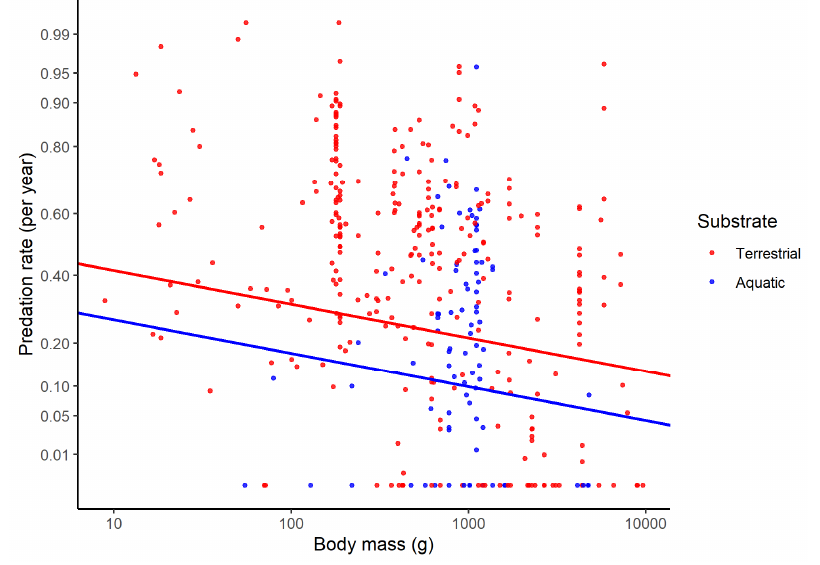
Figure 3. Predation rate expressed on a yearly basis as a function of adult body mass for terrestrial and aquatic species of birds. The regression lines were obtained from a phylogenetic linear mixed model. Predation rate is shown in arc-sine square-root scale, and body mass in log 10 scale.